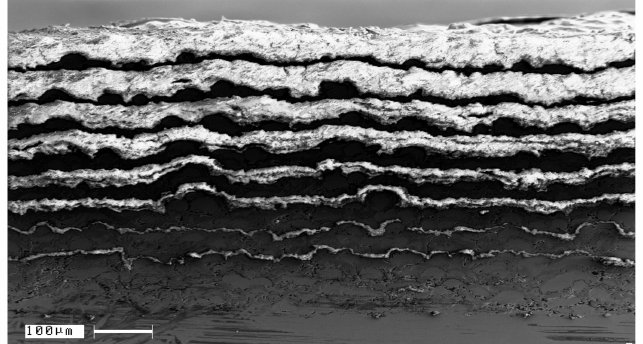
Figure 10. Microstructure of a titanium-alumina graded alternating layer coating: areas adjacent to the substrate are titanium-rich, the subsurface layers are alumina-rich